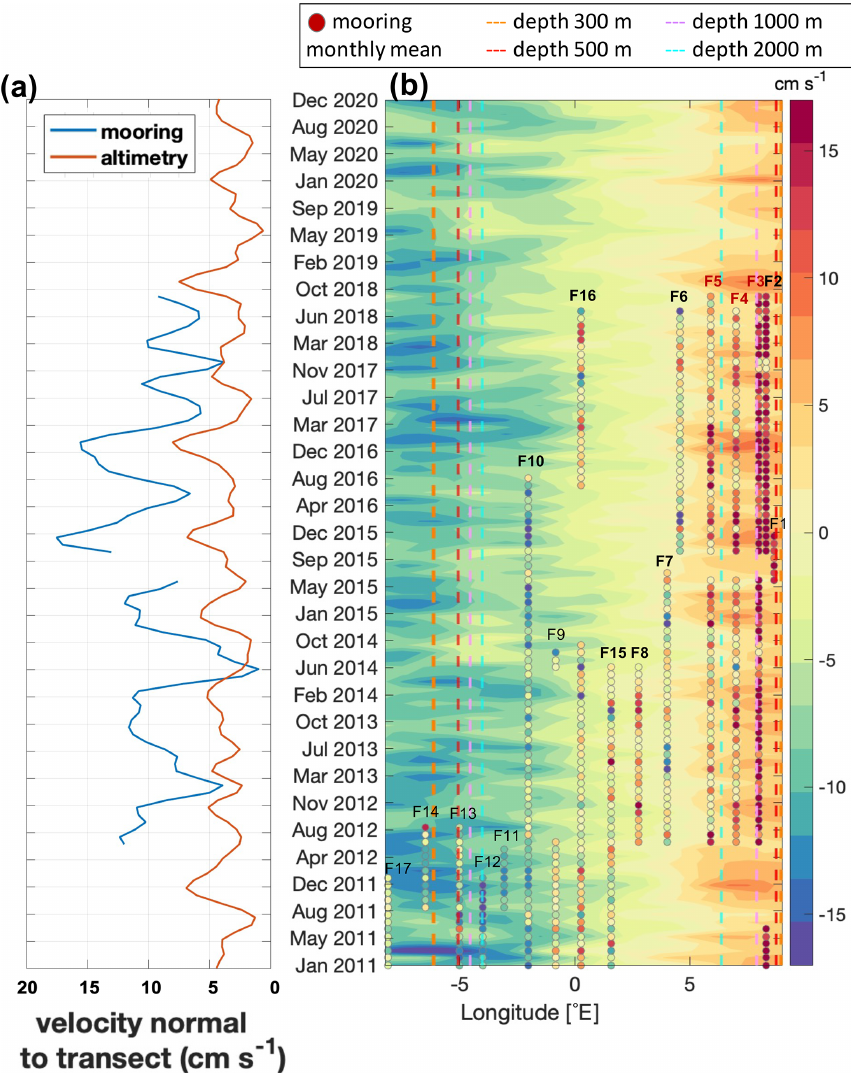
Figure 11. The altimetry-derived geostrophic velocity is shown against the in situ surface velocity at the mooring transects in the Fram Strait, along latitude 78 ◦ 50 (cid:48) N (see Fig. 1). The component of the velocity normal to the transect is evaluated, and positive values represent northward velocity. (a) Longitudinal average of altimetry and in situ velocity across moorings indicated with red letters in panel (b) (corre- sponding to test 2; see Sect. 5.2.2); both time series have been filtered with a 4-month low-pass filter. (b) Hovmöller diagram representing the monthly temporal evolution of the altimetry-derived cross-transect geostrophic velocity. The circles represent monthly mean values of in situ cross-transect velocity. The mooring’s names are displayed on top of each mooring’s series; at moorings with bold letters, data covered a period longer than 24